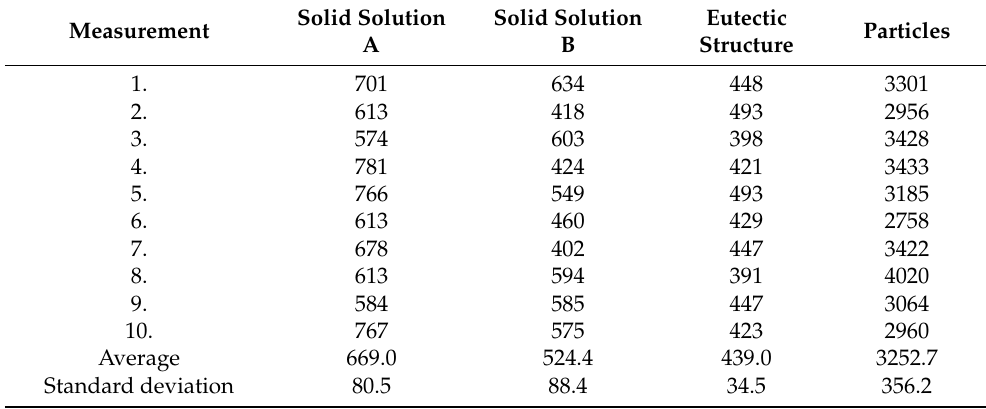
Table 3. Microhardness (HV 0.1) of Co70W12Al15